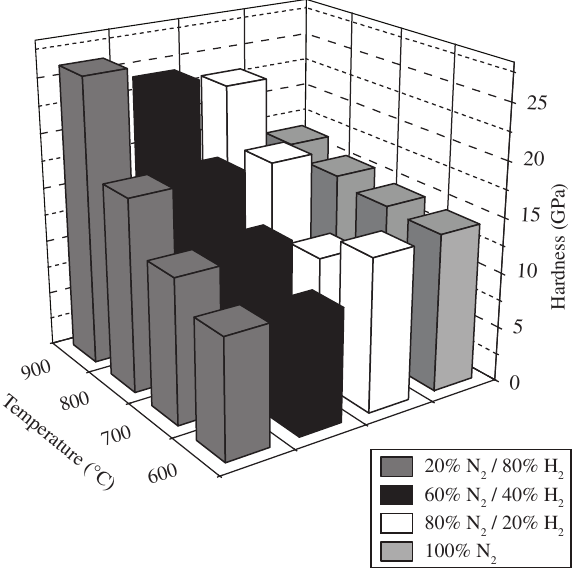
Figure 6. Hardness as a function of temperature and gaseous mixture, obtained at 250 nm in depth, for all titanium working